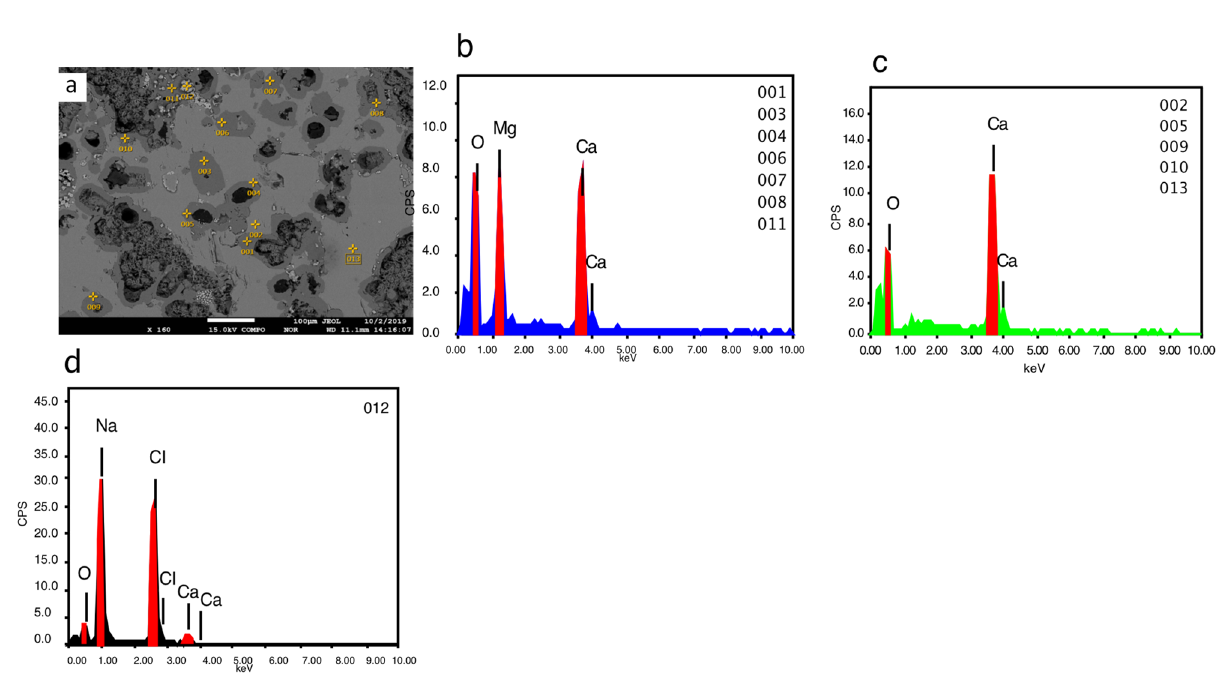
Figure 9. EPMA single point analyses of MV2 sample. ( a ) backscattered electron image of spheroidal dolomite with hollows suggesting channels for methane seepage. The EDS chemical analysis shows the elemental composition of: ( b ) dolomite (points 001, 003, 004, 006, 007, 008, and 011), ( c ) calcite (points 002, 005, 009, 010, and 013), and ( d ) halite (point